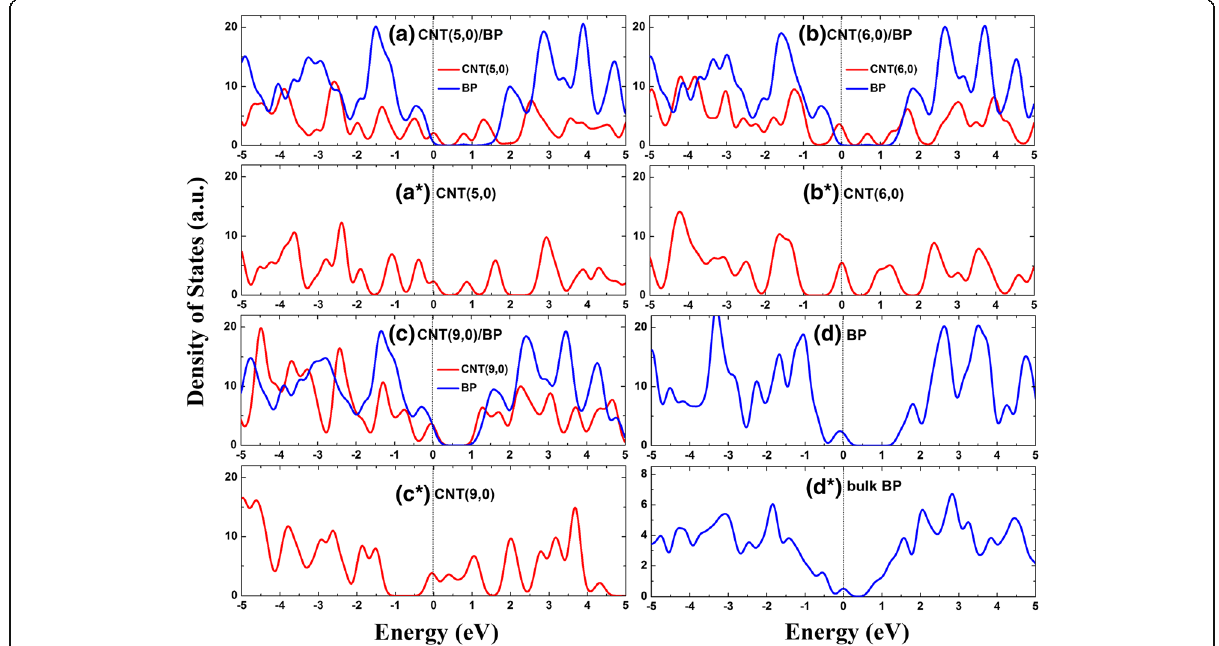
Fig. 3 DOSs for the hybrids ( a ) CNT(5,0)/BP, ( b ) CNT(6,0)/BP, ( c ) CNT(9,0)/BP, ( d ) monolayer BP, ( a *) semiconducting (5,0) CNT, ( b *) metallic (6,0) CNT, ( c *) metallic (9,0) CNT, and ( d *) bulk BP, respectively. The Fermi level is set to